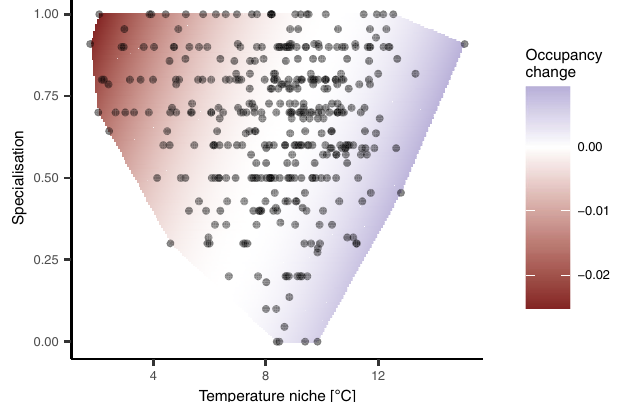
Fig. 5 | Forty-year trends dependent on species traits. Based on the regression model on 5-year trends (Fig. 3), average predicted change in occupancy within a bioclimatic zone across the whole 40-year study period (1980 – 2020) is shown in colouracrossthetemperaturenicheaswellasthehabitatspecialisationgradientof the390studyspecies(pointsshowthetraitrangeofallspecies).Inrelationtomean 40-year occupancy across all species, a change in the occupancy of 0.01 corre- spondsto a decrease or an increase of the distributionofa species in a bioclimatic zone of